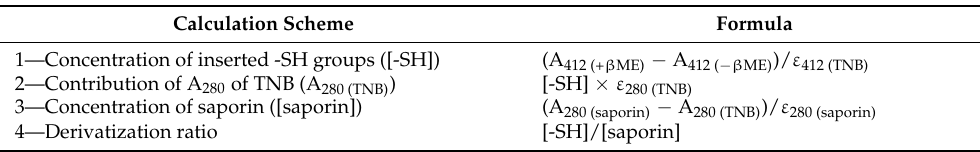
Table 1. Determination of the number of thiol groups (-SH) introduced per protein molecule of saporin derivatized with 2-IT.